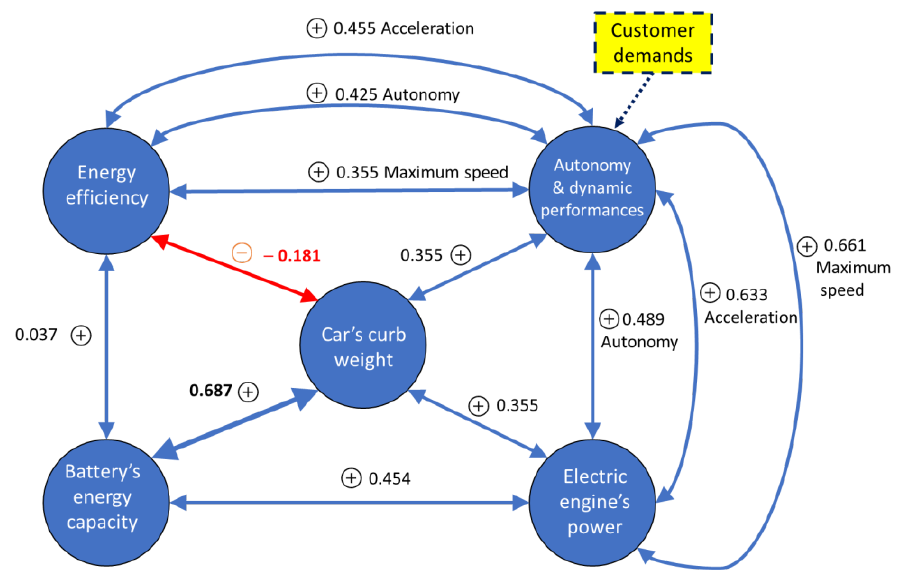
Figure 20. Model of continuous interdependence between the performance and technical parameters of electric cars.